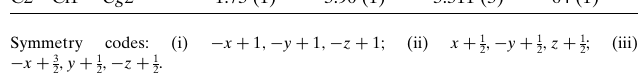
Table 2 Summary of short interatomic contacts (A˚ ) in the title compound.